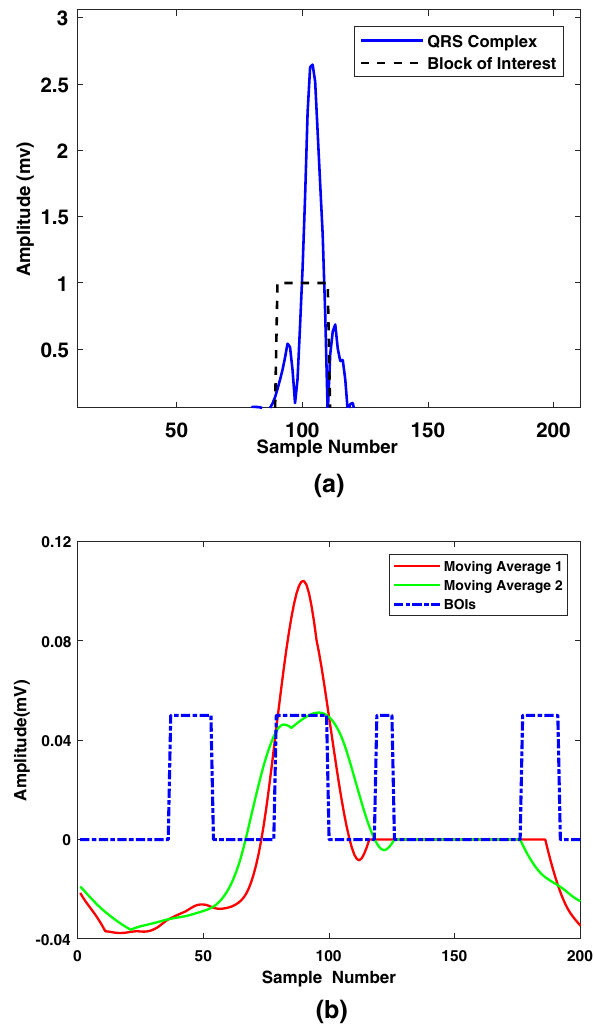
Figure 5. ( a ) Block of interests generation for the detection of R peaks. ( b ) Block of interests generation for the detection of P and T